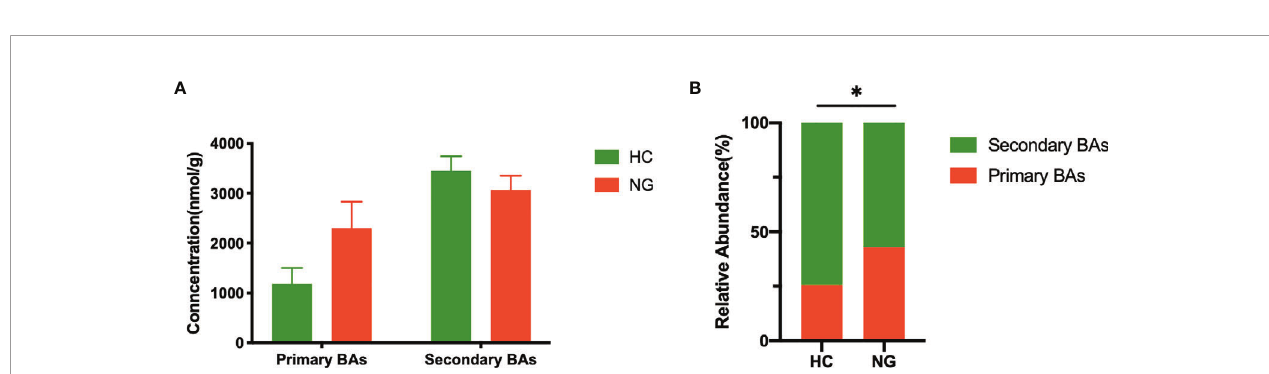
FIGURE 4 | Alteration of fecal primary and secondary bile acid pro fi les in NAFLD children. (A) Pro fi les of fecal primary and secondary bile acids in pediatric NAFLD patients (n=32) and healthy controls (n=36). (B) Proportions of fecal primary and secondary bile acids. The relative abundance of fecal bile acids was evaluated between the two groups by the Mann-Whitney test. *P < 0.05. HC, healthy controls; NG, NAFLD group; BAs, bile acids.